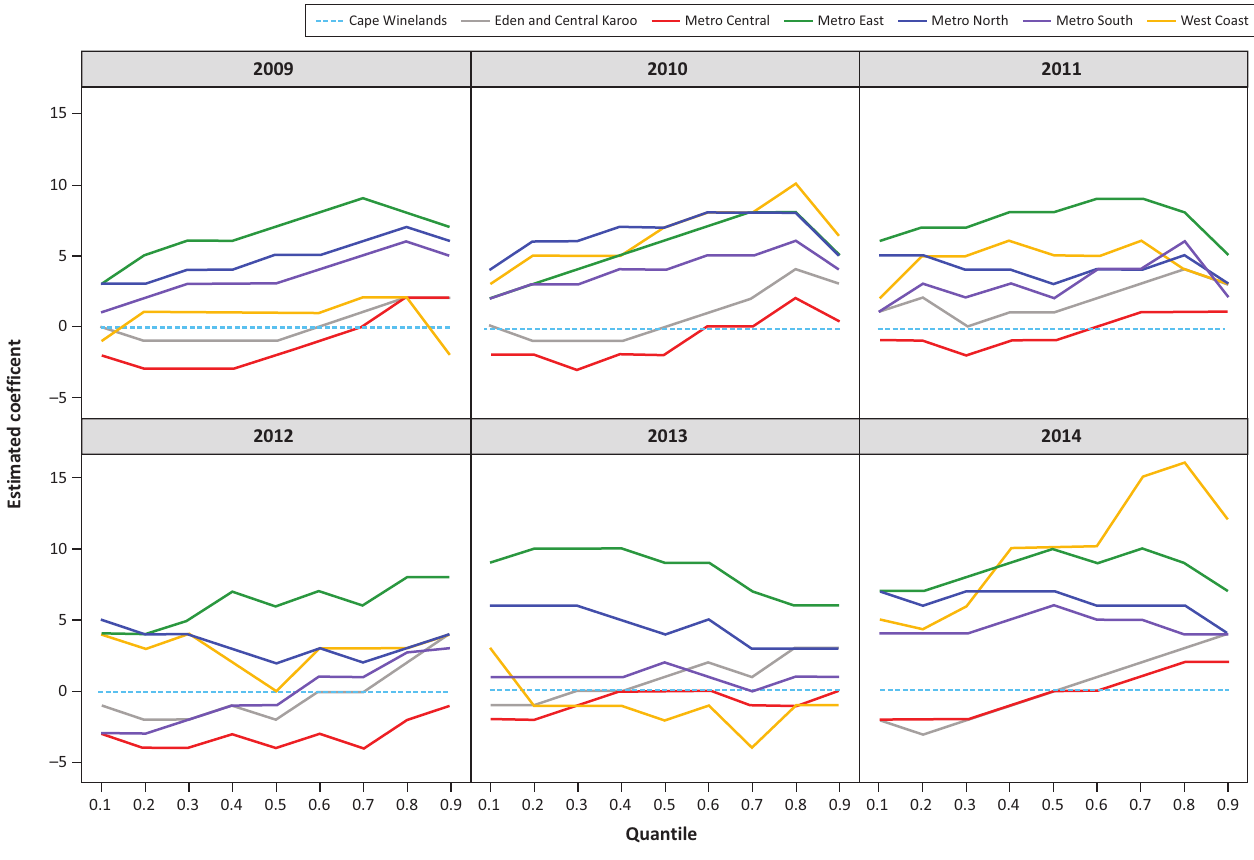
FIGURE 5: Parameter estimate differences between the specified education district and the Cape Winelands education district across the different